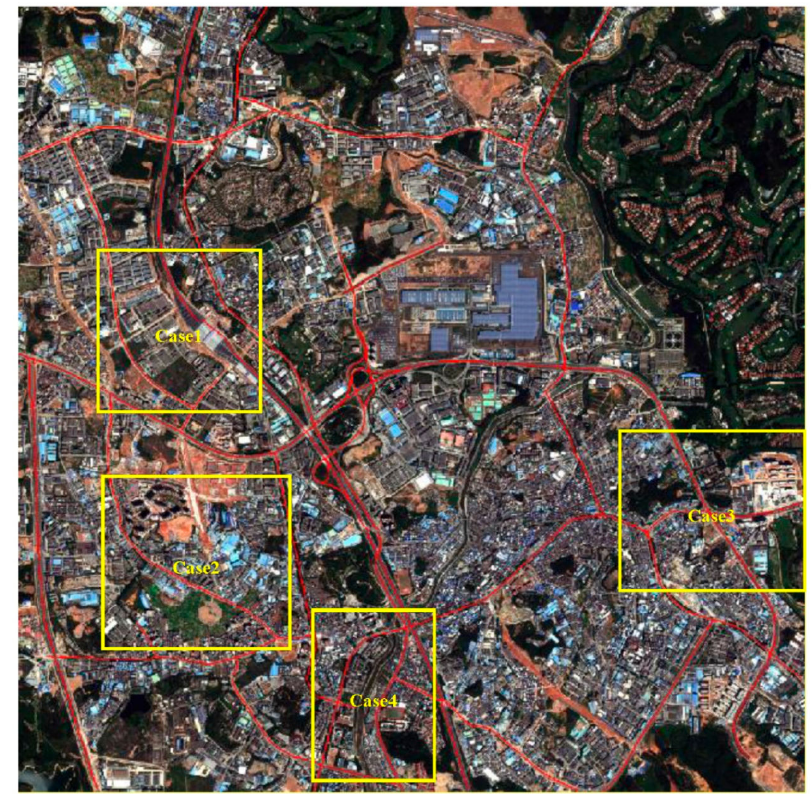
Figure 8. Road extraction result provided by the proposed ECFM method for a WorldView-2 image.